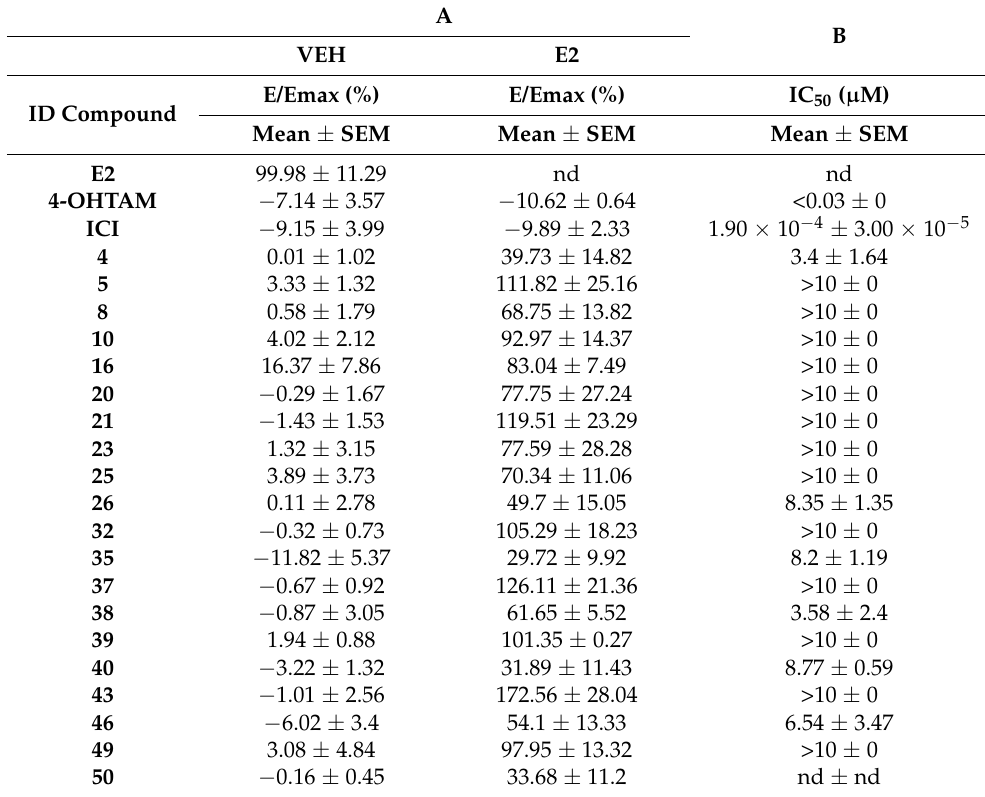
Table 2. Chemical screening of representative 5-hydroxy-2 H -pyrrol-2-ones on ER-dependent tran- scriptional activity. T47D-KBluc cells were seeded in E2-depleted growth media (5%DCC-FBS) and pretreated with (A) compounds (10 µ M) or with (B) a dose-response (1 µ M–10 µ M) for 3 h, before the addition of vehicle (VEH; 0.05% DMSO) or E2 (0.1 nM) for 16–24 h. ICI 182,780 (ICI; 0.03 –10 nM) and 4-hydroxy-tamoxifen (4-OHTAM; 0.03–1 µ M) were used as antagonism controls. Relative